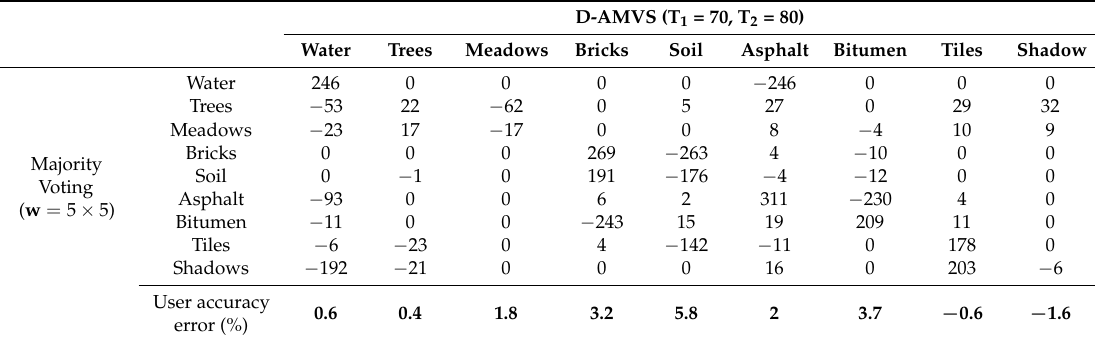
Table 10. Error estimation between the proposed D-AMVS and majority voting approach in terms of user accuracy for the Pavia Center image